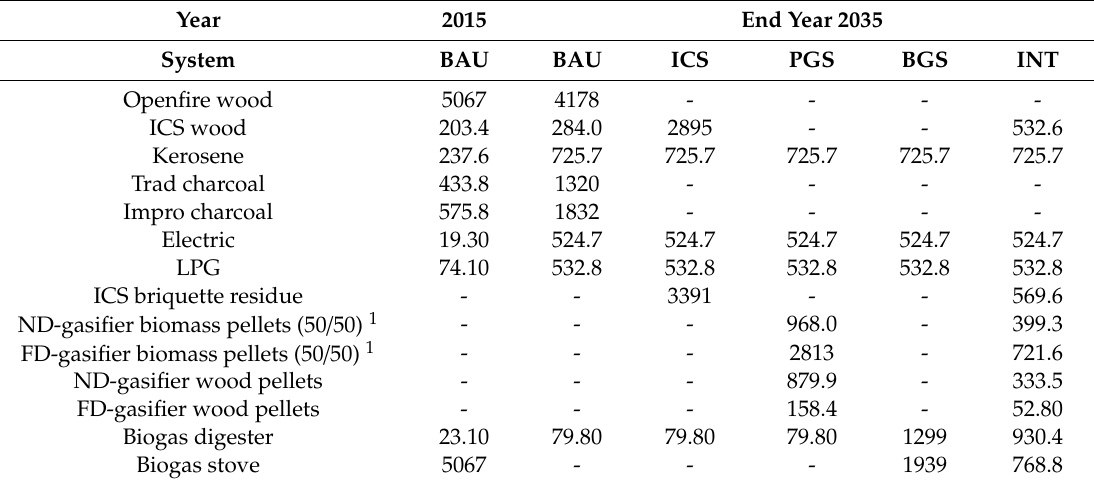
Table A4. Energy inputs in the cooking life-cycle stage (TJ), considering each cooking